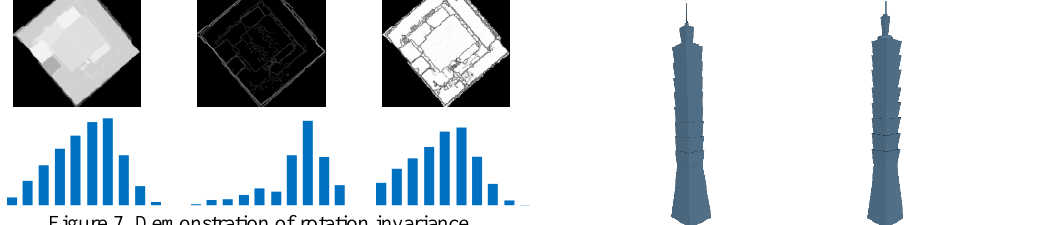
Figure 7. Demonstration of rotation invariance.